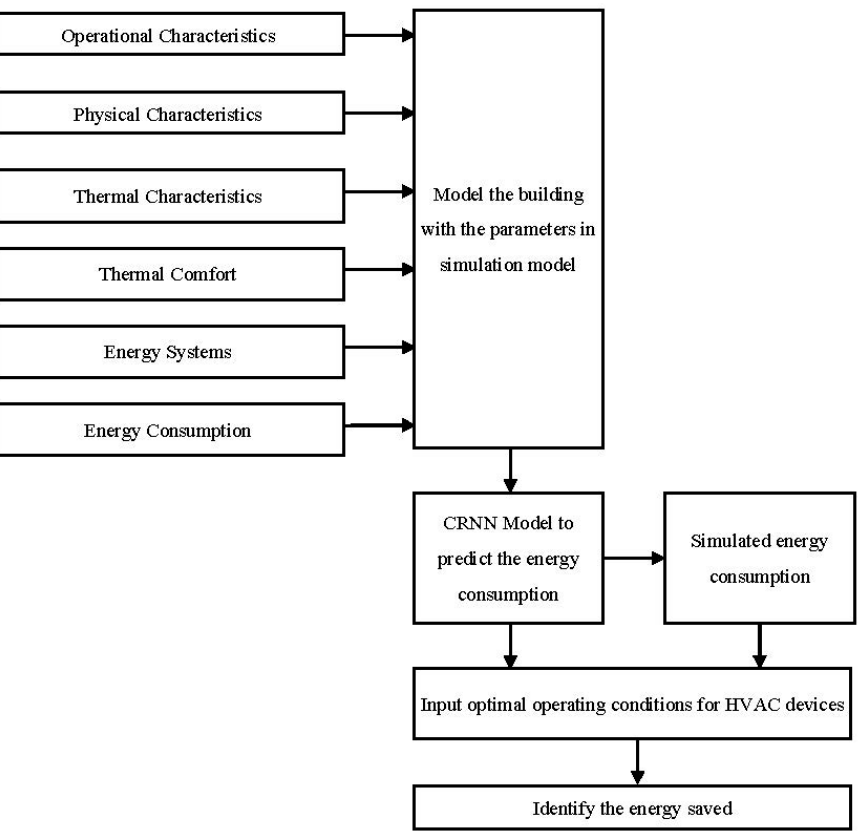
Figure 1. Overall architecture of the energy consumption prediction model. HVAC: Heating, Ventilation and Air Conditioning and CRNN: Convolutional Current Neural Network.